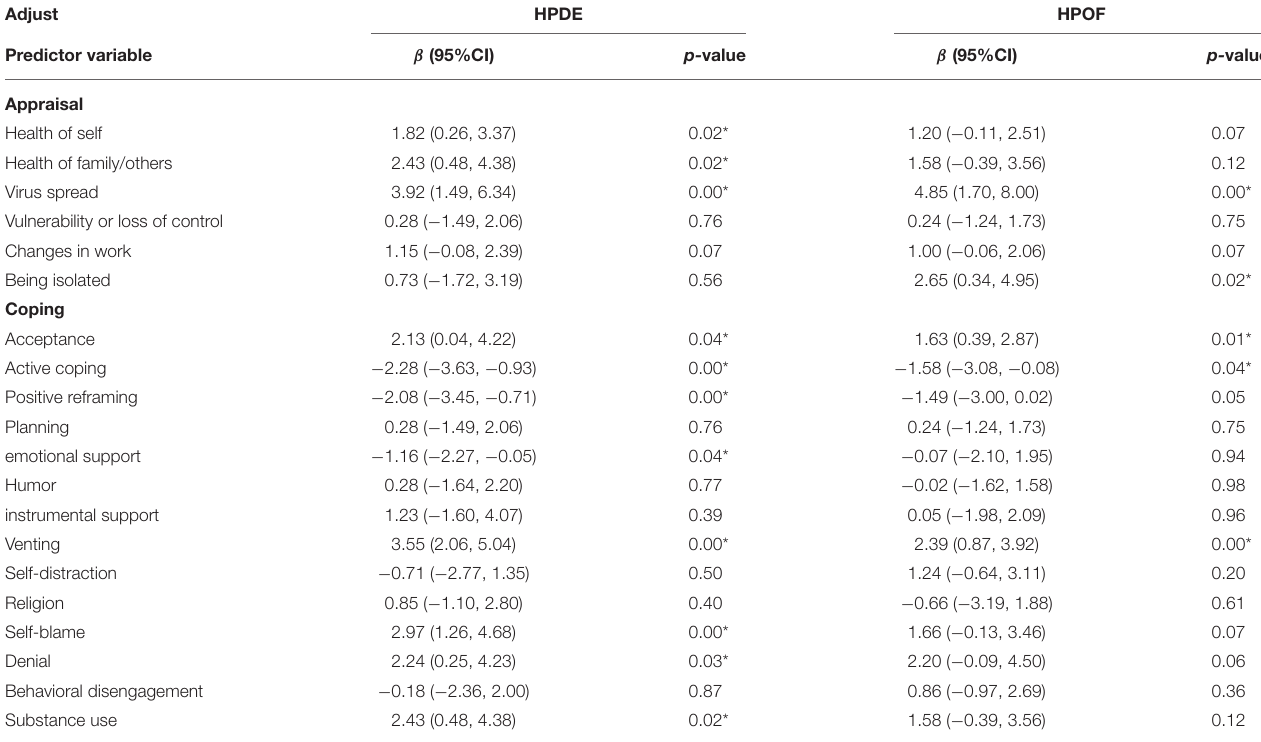
TABLE 5 | Association between IES-R scores with appraisal and coping variables, in multivariable linear regression analysis with IES-R as dependent variable ( N = 723). Adjust HPDE HPOF Predictor